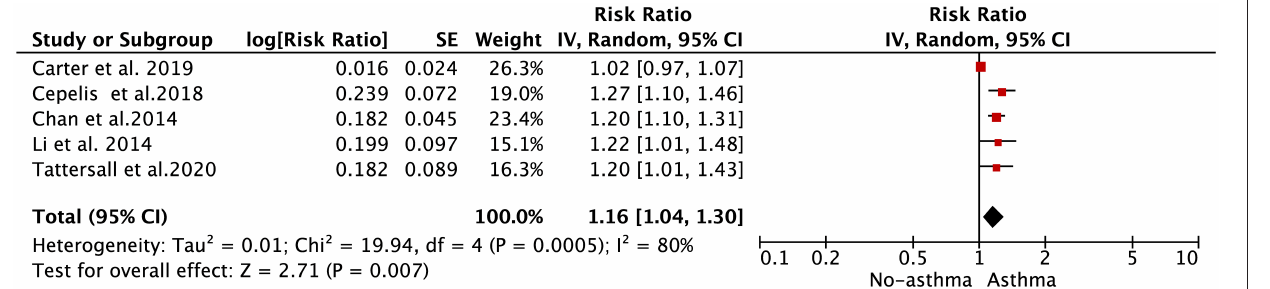
Frontiers in Cardiovascular Medicine |